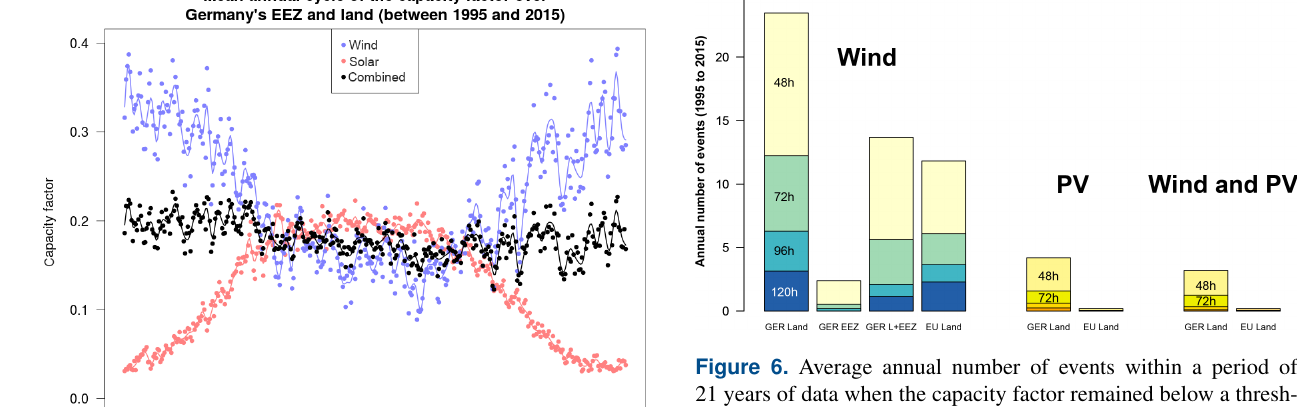
derived for wind when looking at the European instead of the German scale.